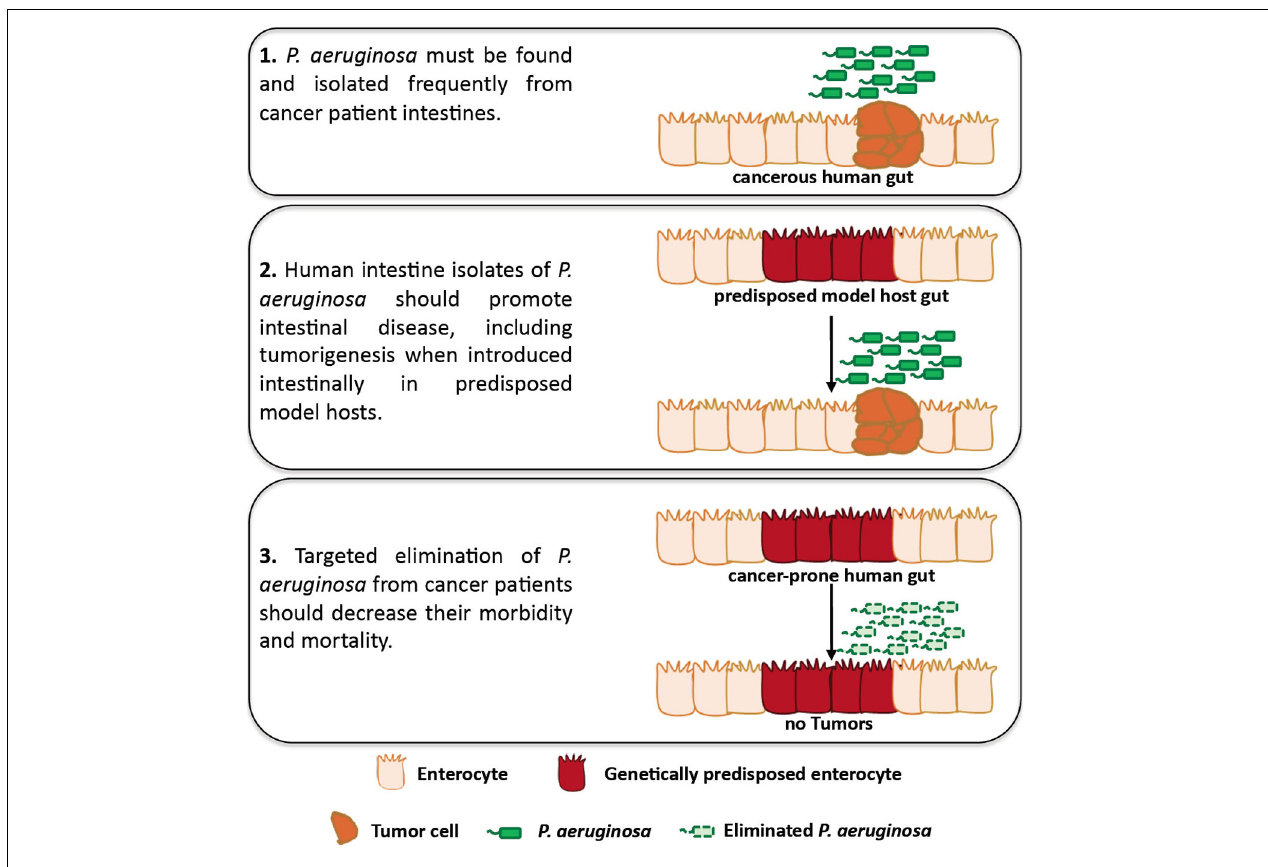
FIGURE 1 | An adaptation of Koch’s postulates assessing causation between intestinal P. aeruginosa and disease in patients with cancer. Studies using Drosophila and mammalian hosts may assess the role of P. aeruginosa in facilitating intestinal disease, including intestinal P. aeruginosa